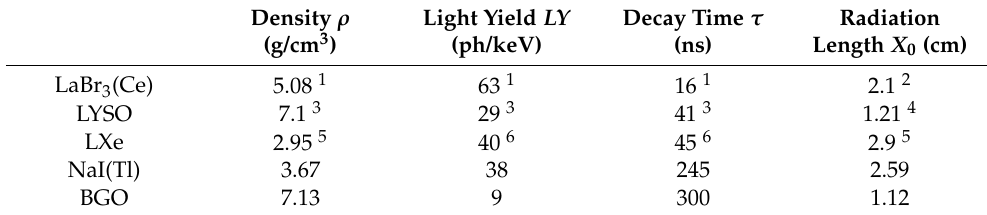
Density ρ (g/cm 3 )